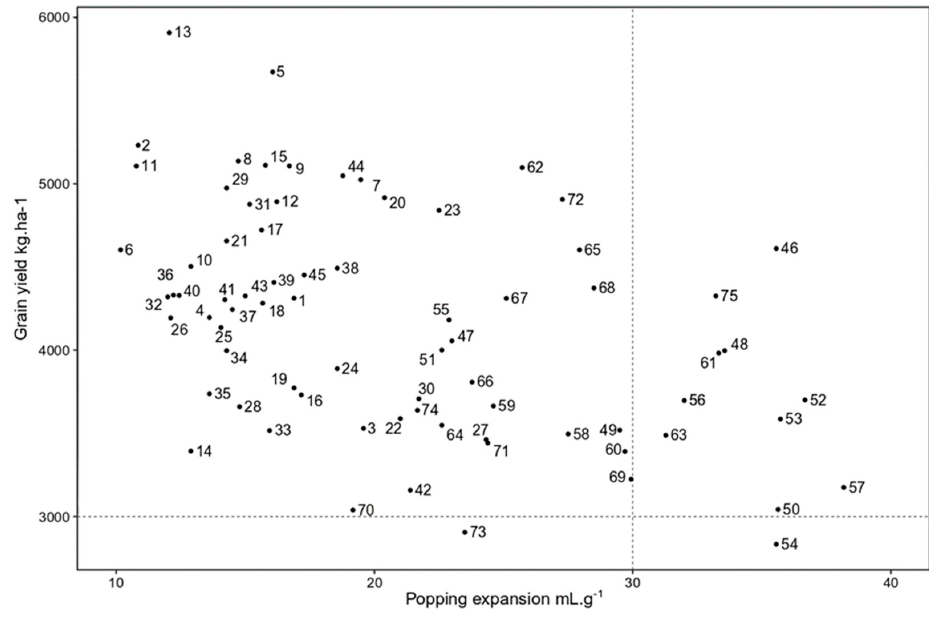
Figure 3. Graphical dispersion of 75 popcorn hybrids based on grain yield and popping